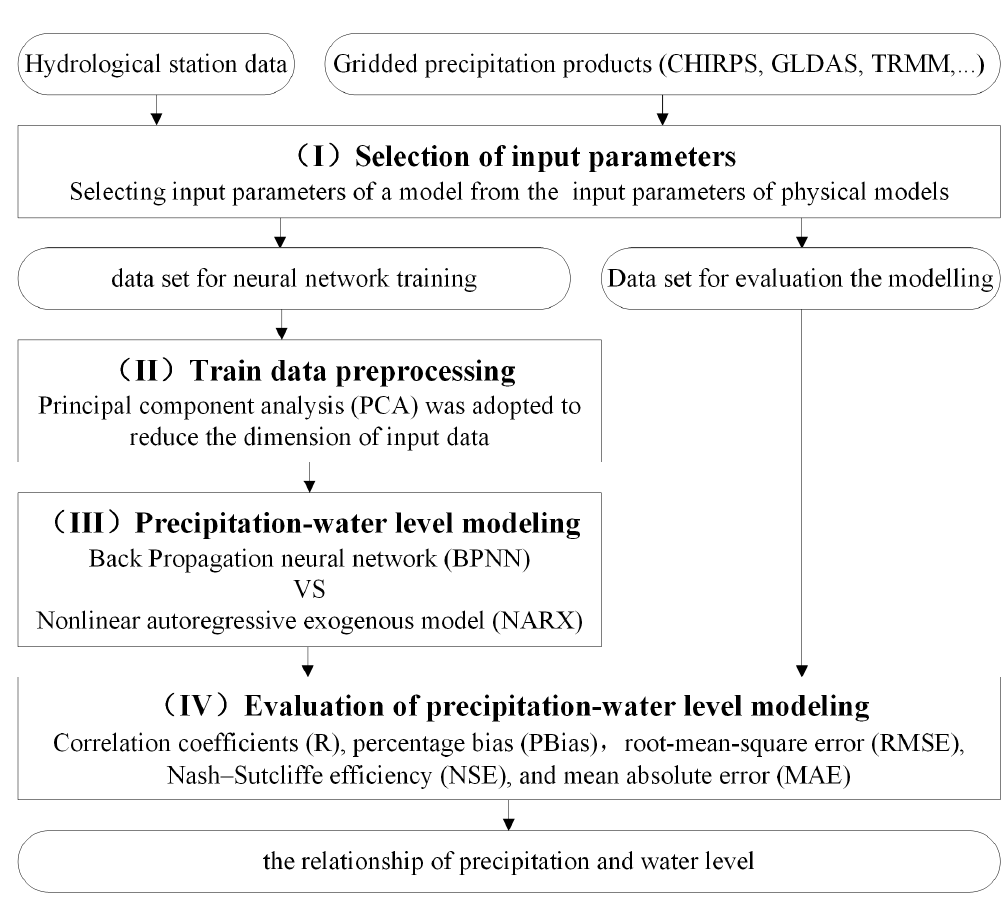
Figure 2. Main processes of modeling the relationship of precipitation and water level using grid precipitation products with the neural network